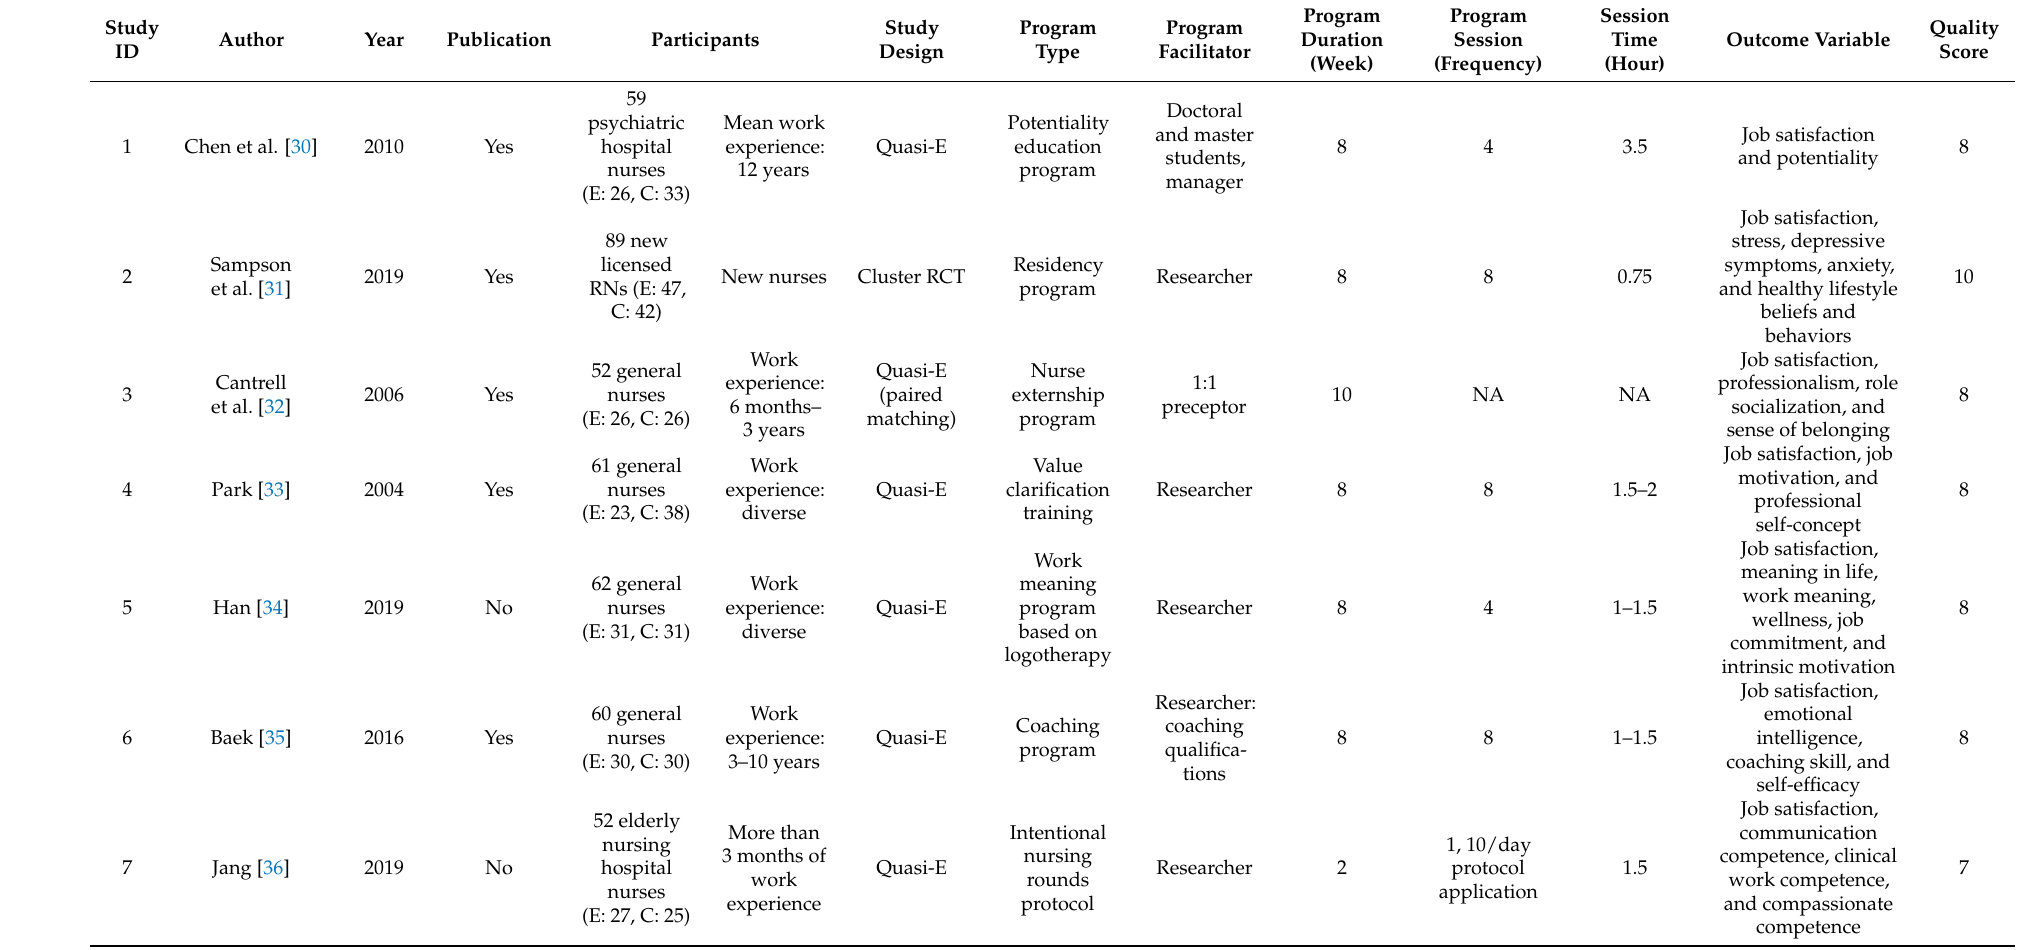
Table 2. Descriptive summary of the included